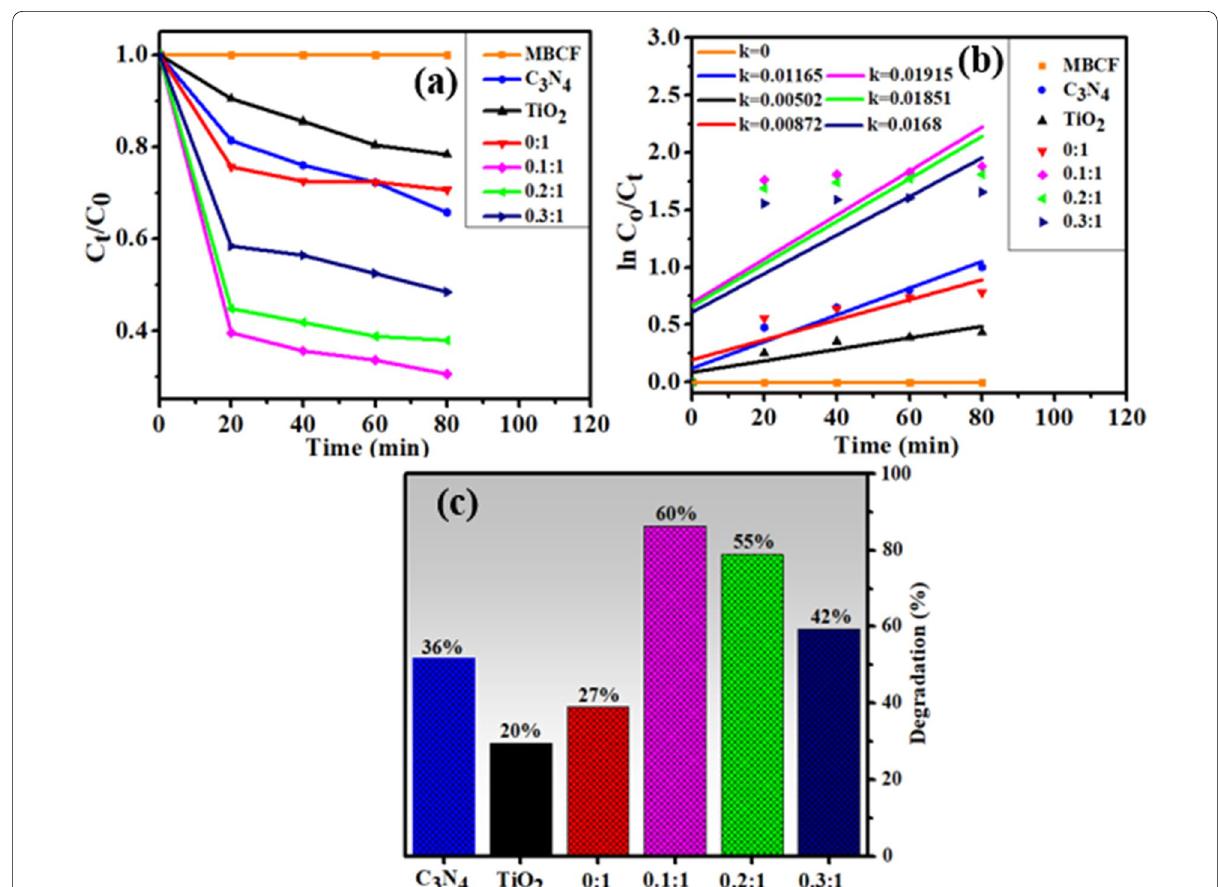
Fig. 8 a Plot of concentration ratio ( C t / C o ) versus time, b plot of ln( C o / C t ) versus time spectra for dye reduction, c percentage (%) degradation of prepared